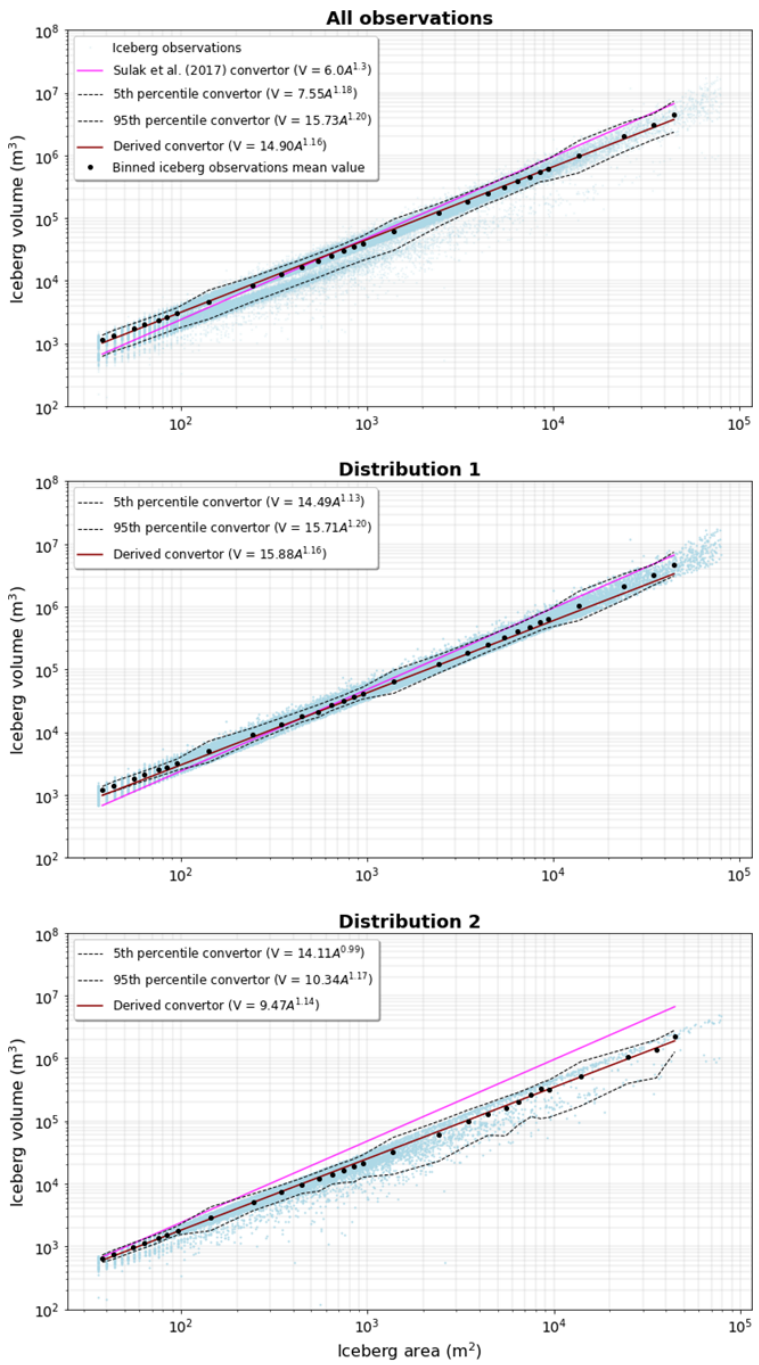
Figure 7. The mean iceberg area and volume for each size class (e.g. mean of 30–40m 2 , mean of 100–200m 2 , mean of 1000–2000m 2 and so on) for each glacier, overlaid with the Sulak et al. (2017) conversion (pink) and the one derived here (brown). By calculating mean iceberg area and volume within log 10 ( A + 0.1) binned increments, this reduced the potential for biasing area–volume relationships towards smaller, more frequently observed icebergs. The top plot contains all the icebergs in the dataset for each glacier, while the middle and lower plots contain the icebergs residing in distribution 1 and distribution 2, respectively. Uncertainty in these distributions is also characterised by deriving similar relationships for the 5% and 95% limits. To note, these limits are derived from the binned mean size classes and are therefore not